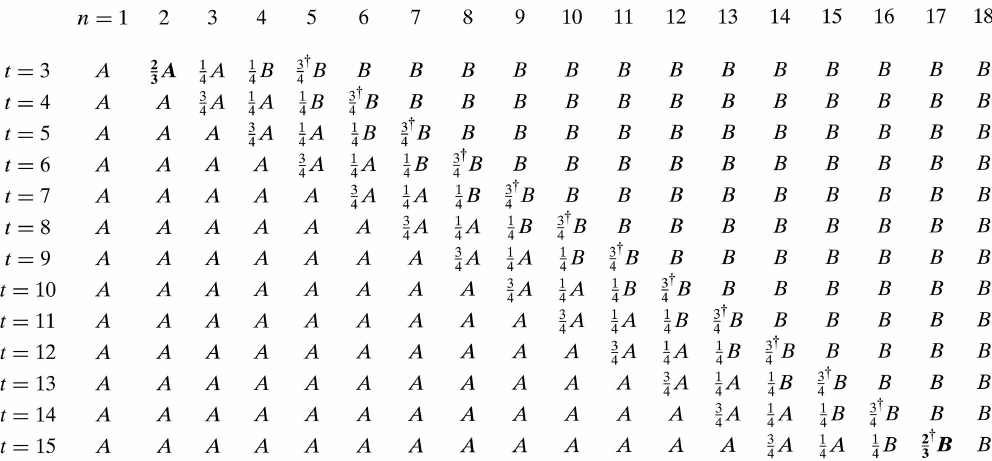
Figure 11 The full matrix (13 (cid:6) 18) of the coefficients; for simplicity’s sake K A and K B are indicated with A and B , respectively – see text. To improve the small but non-negligible kick between the two modulators, at position n = t + 2 the coefficient (indicated with a † sign) has to be reduced by about a percentage: the measured value was saved in lookup tables for the operation.